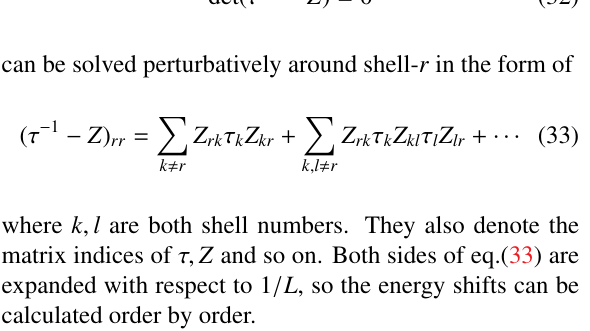
. AD thresh- 1 Figure 12: The lower blue line is the theoretical calcula- tion for energy shifts of ground states up to O (1 / L 6 ). The upper blue line is for the excited states in A + as well. The two red lines are the calculation for higher ex- cited states at the next to leading order, that is O (1 / L 3